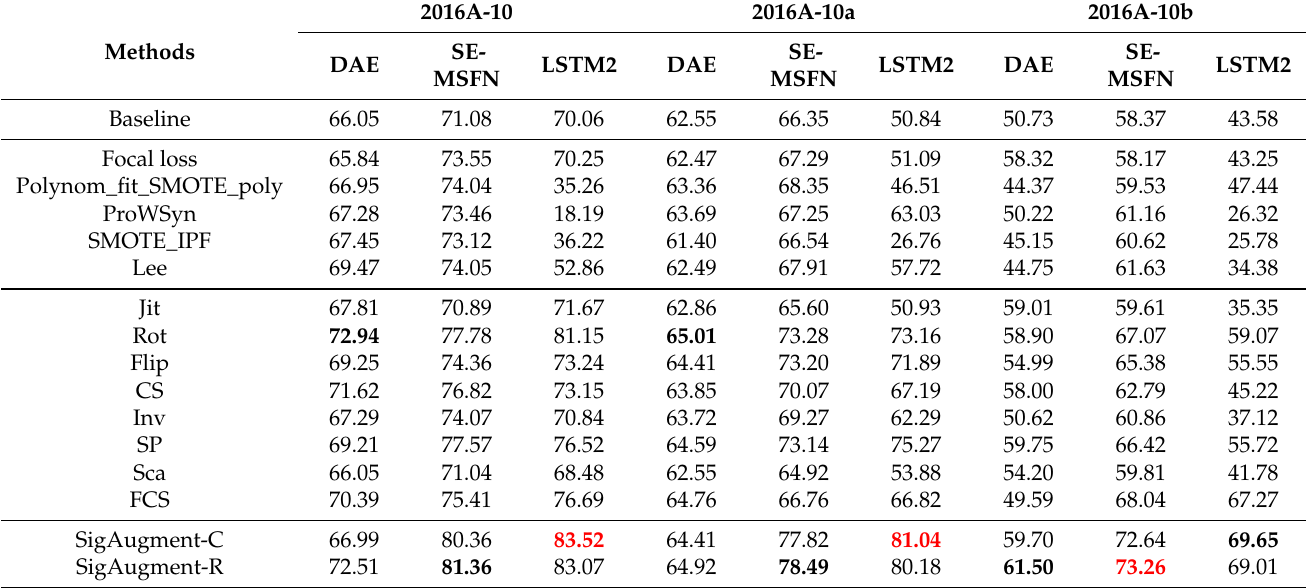
Table A1. On three class-imbalanced datasets, 2016A-10, 2016A-10a, and 2016A-10b, the proposed methods were compared to existing representative class rebalancing methods and individual trans- formations. The accuracy (%) is calculated as the mean of three experiments. The best-performing individual model results are shown in bold, while the best-performing dataset results are shown in bold and